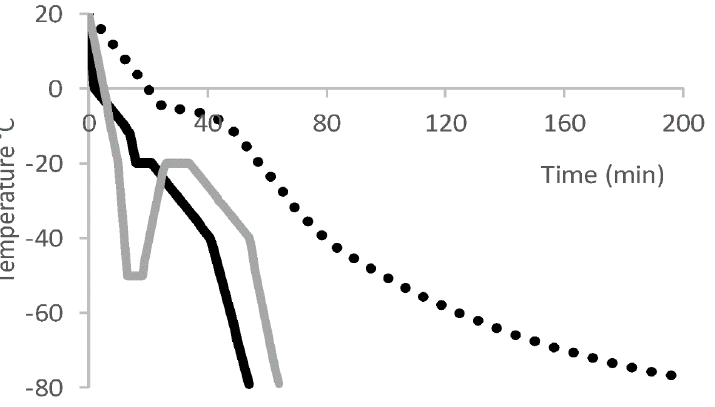
Figure 2. Example freezing rate profiles used to cryopreserve T cell. Dotted black line = passive freezing [63] ; solid black line = CRF with 5-min hold time at − 20 °C (dissipate heat of crystallisation) [65] ; solid gray line = CRF with annealing step from − 50 to − 20 °C followed by a 10- min hold.